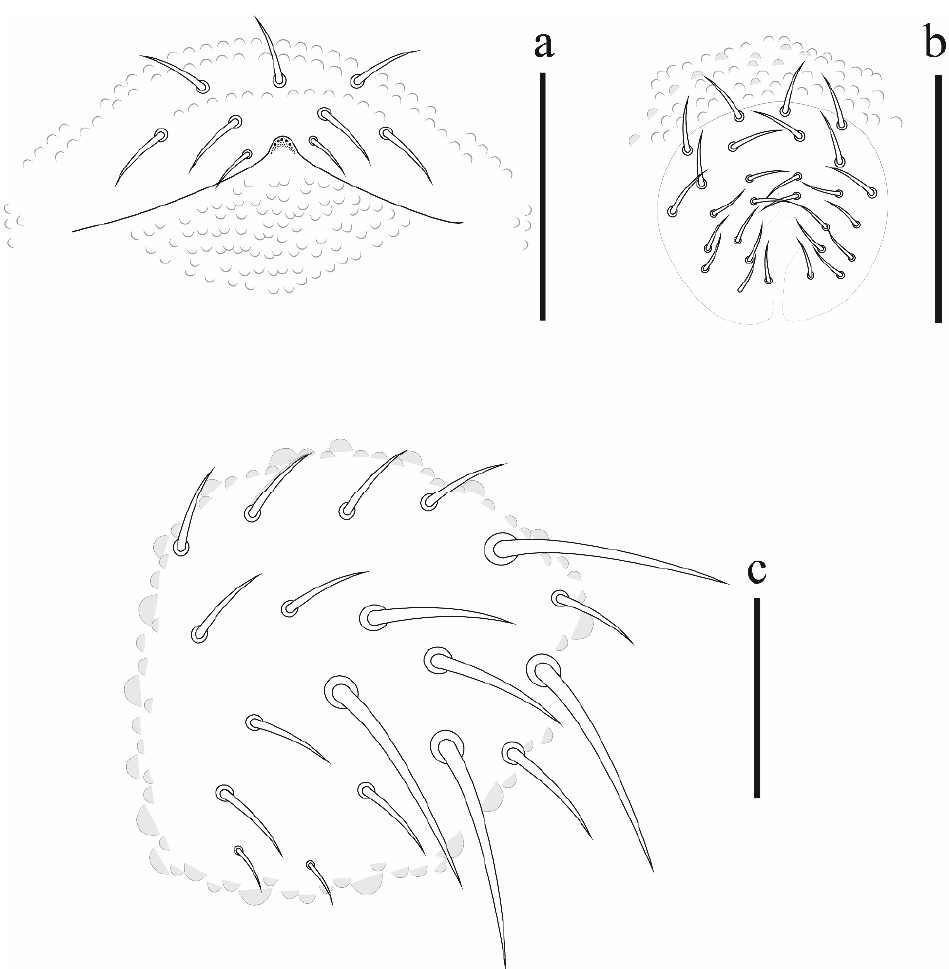
Figure 9. Friesea rochedoensis sp. nov. ( a ) female genital plate, scale bar: 20 µm. ( b ) male genital plate, scale bar: 20 µm. ( c ) left anal valve, scale bar: 20 µm.